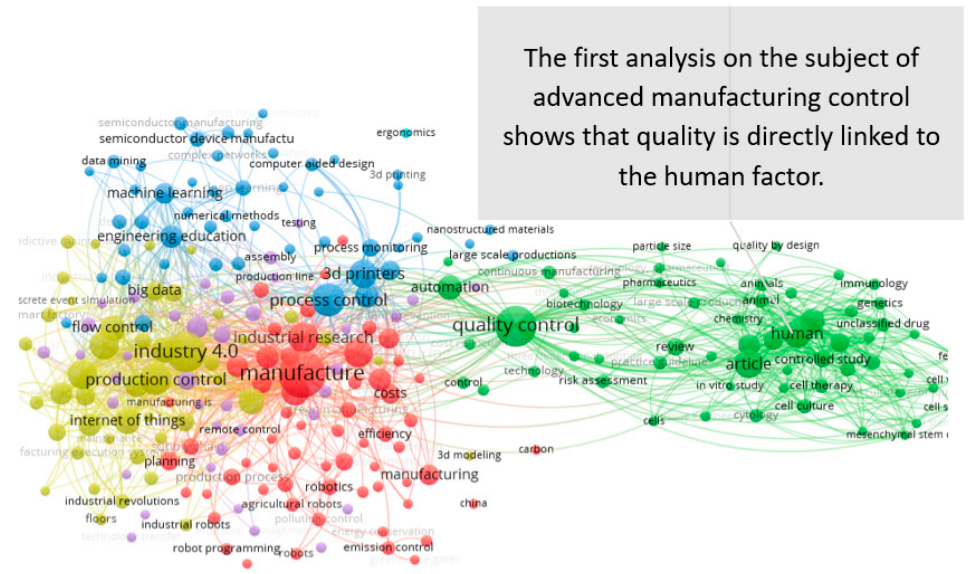
Figure 16. VOSviewer Result—advanced manufacturing control.